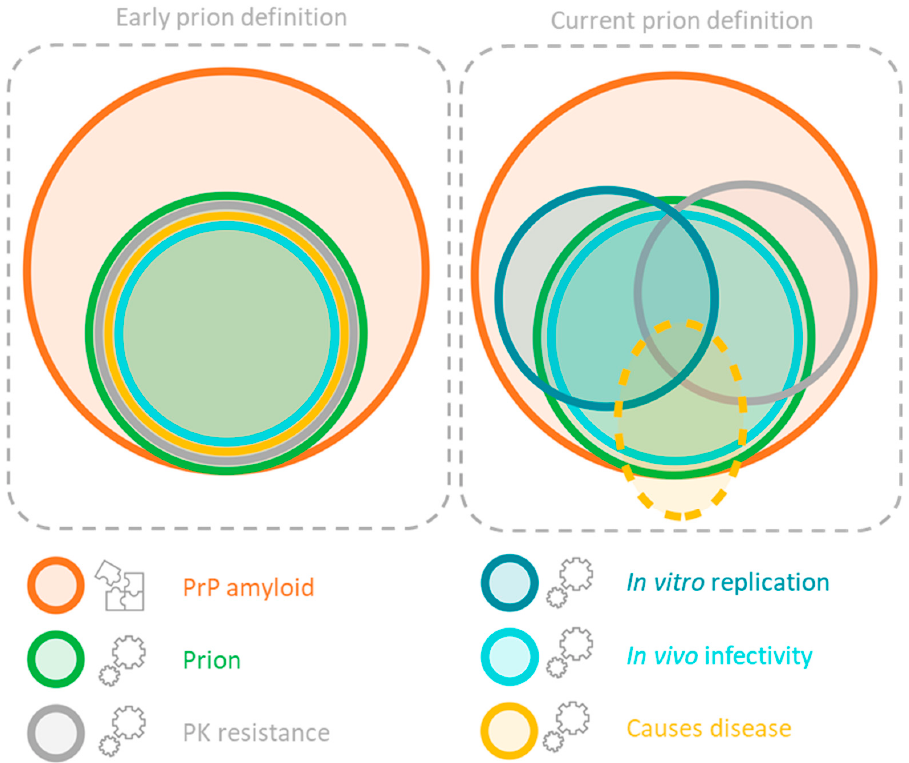
Figure 2. Whilst the core of the definition of a prion as an infectious protein structure as stated by Prusiner has remained, the boundaries of its definition have since blurred as protein assemblies, which are not infectious in vivo, can possess traits that were thought to be specific for prions. PrP amyloid (orange) is defined by is structure, a PrP protein sequence with a cross- β -sheet structure, whereas a prion (green) is defined by its biological activity (light blue). All solved structures of bona fide prions are PIRIBS amyloids, suggesting that amyloid can contain prion-like traits. However, biochemical properties such as PK resistance (grey) and in vitro replication (dark blue) that are used as proxies for the detection of prions are shared by amyloid assemblies, which are not infectious in vivo. The dashed line (yellow) signifies that much is still unknown about how prions cause disease—the toxicity may be caused by a non-protein species downstream of the prion, as well as by the prion